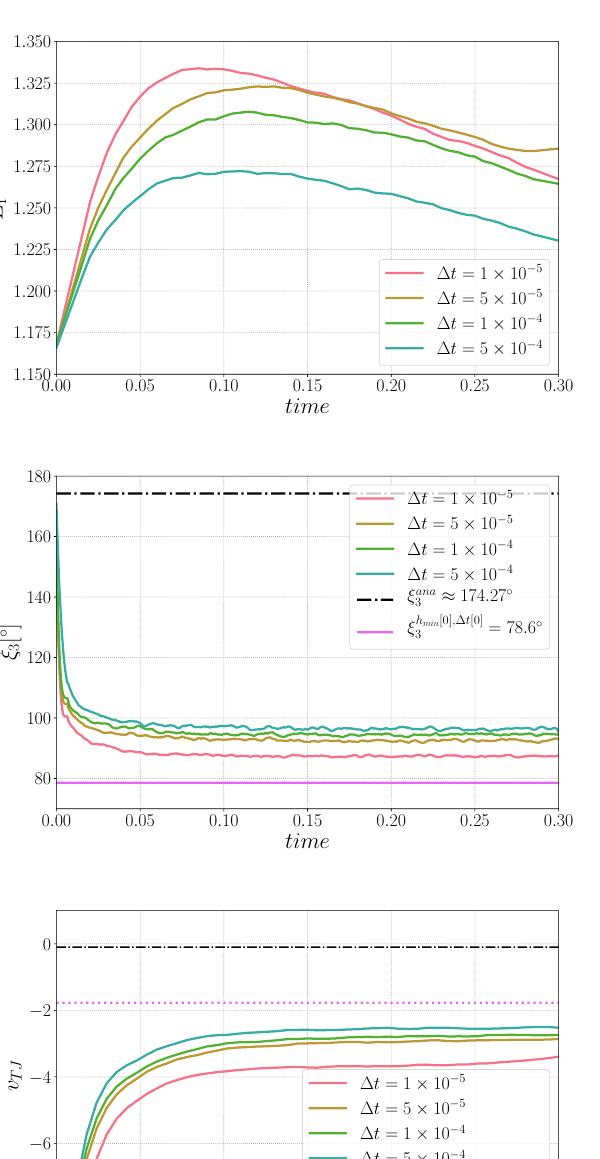
Figure 5. Sensibility analysis for the Het formulation in ( left ) time for h min = 1 ∆ t = 1 10 − 4 : ( Top ) interfacial energy sensibility, ( middle ) triple junction angle, ξ 3 , sensibility analysis, and ( bottom ) × triple junction velocity, v TJ , sensibility